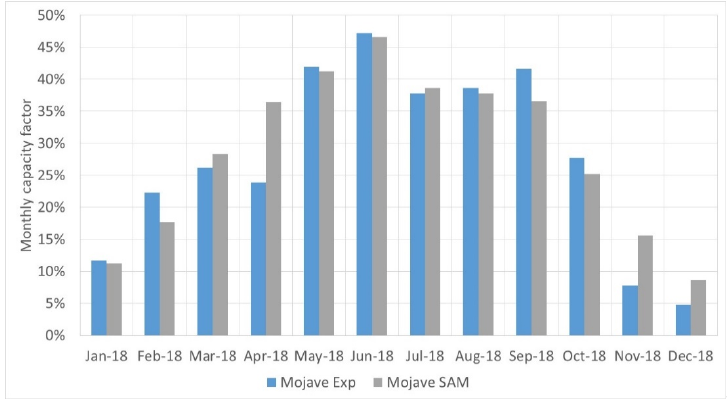
Figure 4. Google Earth view of Mojave solar energy project. Map data ©2020 Google.